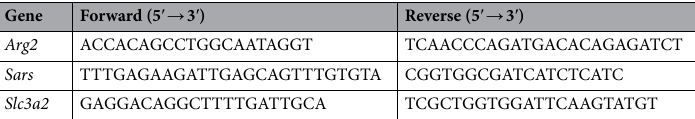
Table 1. Forward and reverse QPCR primers for the murine